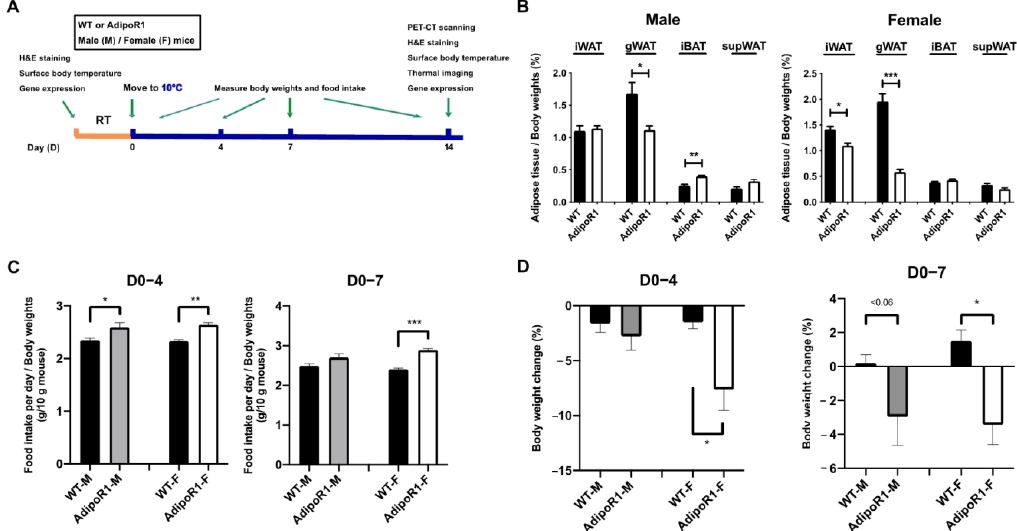
Figure 1. Body profiles of AdipoR1 mice upon cold exposure. ( A ) Wild-type (WT) and transgenic adiponectin receptor 1 (AdipoR1) mice of both sexes, male (M) and female (F), were housed in a cold-room (8–10 °C) for two weeks, i.e., 14 d. ( B ) Percentage of adipose tissue weights was expressed per unit body weights in WT or AdipoR1 mice. Subcutaneous inguinal white adipose tissues (iWAT), gonadal/epididymal white adipose tissues (gWAT), classical interscapular brown adipose tissues (BAT), and suprascapular white adipose tissues (supWAT) were harvested and weighted. ( C ) AdipoR1 mice had increased food intake (averaged g of feed per mouse per d/g of mouse body weights) while losing more body weight than WT mice. ( D ) AdipoR1 mice had significant body weight changes with enhanced body weight losses. Body weight changes were calculated and compared with each previous time point as percentage (%). Data were presented as means ± SEM ( n = 3–8 for each group). * p ≤ 0.05; ** p ≤ 0.01; *** p ≤ 0.001.